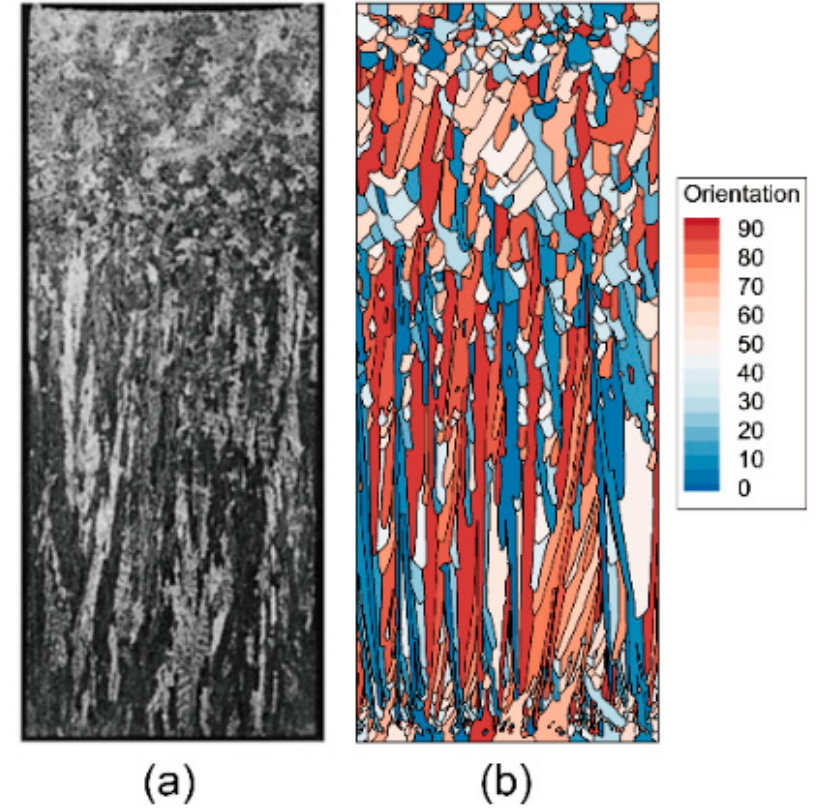
Figure 10. Comparison of grain texture: ( a ) Experiment; ( b ) Simulation.